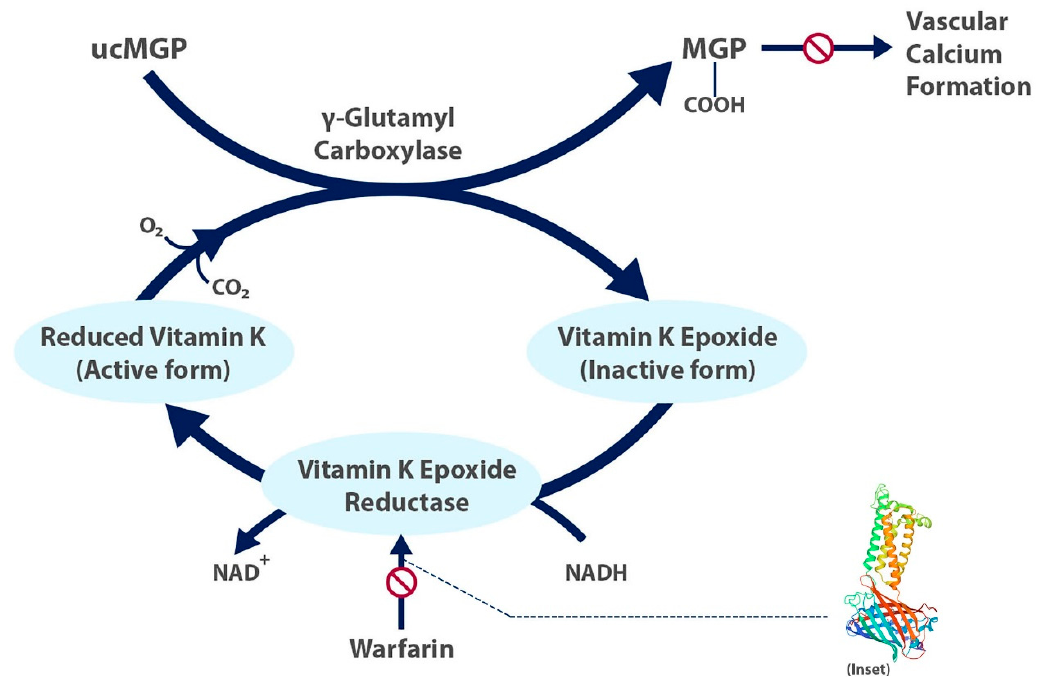
Figure 1. The carboxylated, active form of matrix gla protein prevents vascular calcium formation and relies on the active form of vitamin K. Warfarin inhibits formation of the active form of vitamin K. Inset shows structure of human vitamin K epoxide reductase with warfarin [12] . ucMGP = uncarboxylated matrix gla protein.